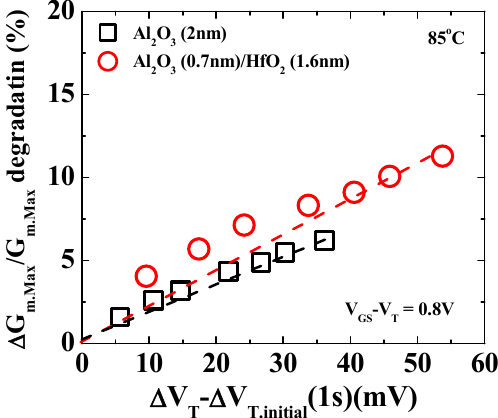
Figure 5. ∆ V T − ∆ V T.initial (1 s) shift versus %G m.Max degradation in In 0.7 Ga 0.3 As MOSFETs with single-layer Al 2 O 3 and bi-layer Al 2 O 3 / HfO 2 gate stacks. Correlation between ∆ V T − ∆ V T.initial (1 s) and %G m.Max degradation is detectible in single-layer Al 2 O 3 and bi-layer Al 2 O 3 / HfO 2 gate stacks. Although the bi-layer Al 2 O 3 / HfO 2 gate stack in In 0.7 Ga 0.3 As QW MOSFETs demonstrated